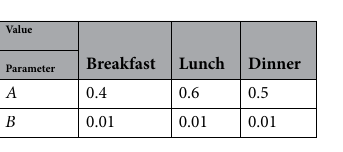
Table 2. Disturbance